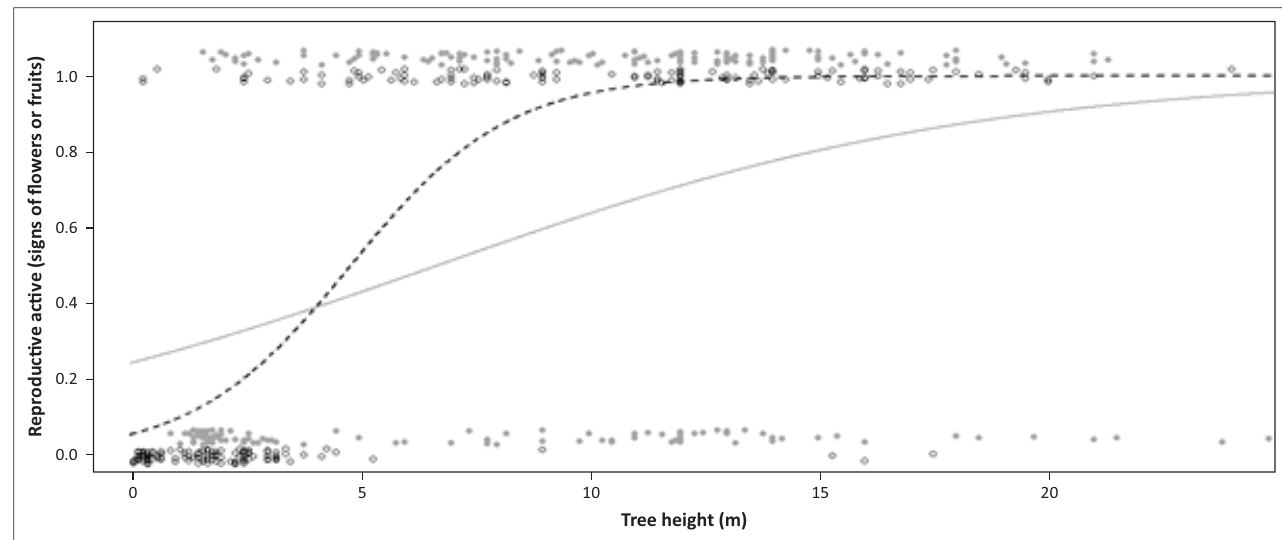
FIGURE 3: Height at first flowering of Graskop sites (black circles–dotted black line) and White River sites (dark grey solid circles–solid dark grey line). The Graskop data have been shifted up slightly (using the R function ‘jitter’) to make the comparison